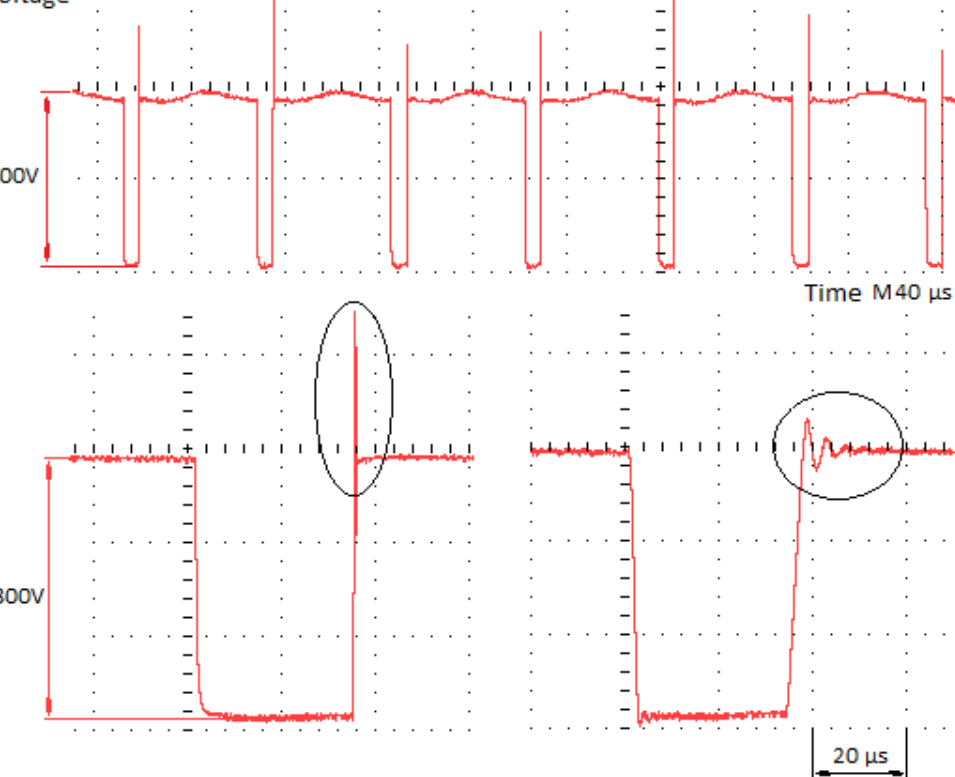
Figure 15. Boost mode of operation. Voltage drain-to-source, boost transistors Q2, module M2.